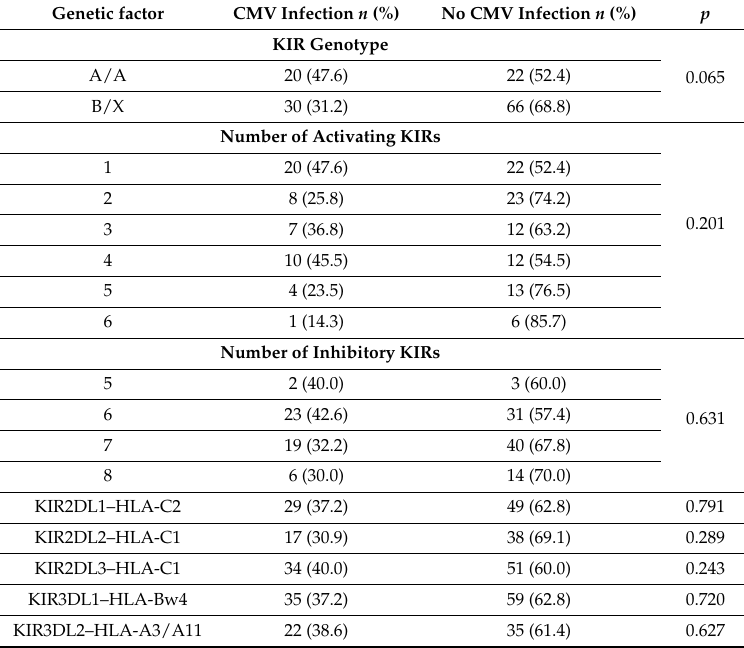
Table 3. Association between KIRs and KIR genotypes and CMV infection.